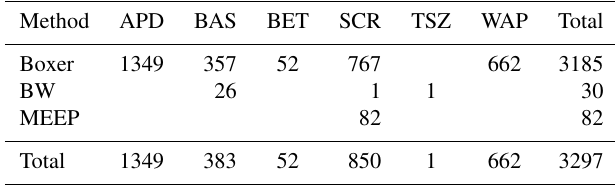
Table 1. Earthquakes with MDPs in each calibration region and method used for assessing parameters. APD: Apennines, north-eastern Alps and Dinarides; BAS: broad Aegean, shallow; BET: Betics; IVA: Italian volcanic areas; SCR: stable continental region; WAP: Western Alps and Pyrenees.